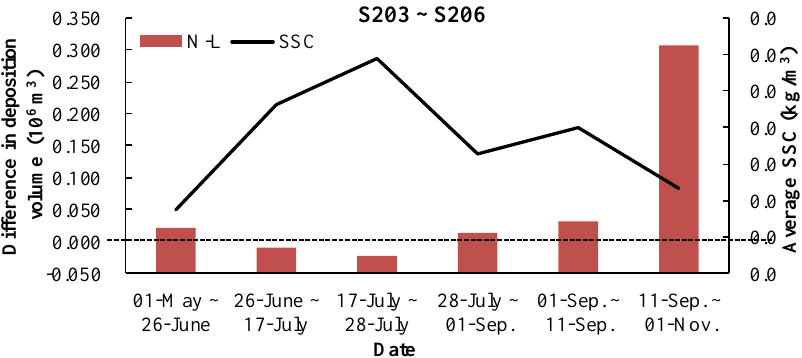
Figure 8. Di ff erences in deposition volume during di ff erent periods (average SSC means the average Figure 8. Differences in deposition volume during different periods (average SSC means the average suspended sediment concentration during each suspended sediment concentration during each period).